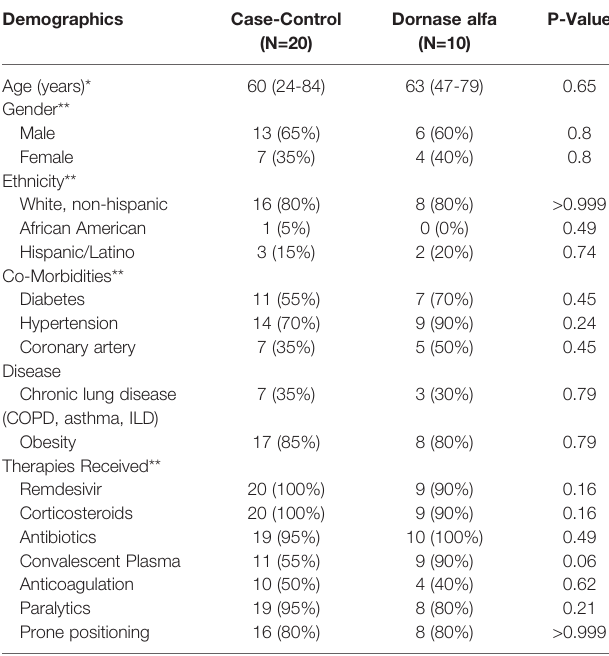
TABLE 1 | Demographics and concurrent medical therapies of patients in the case-control group (N=20) and Dornase alfa treatment group (N=10).